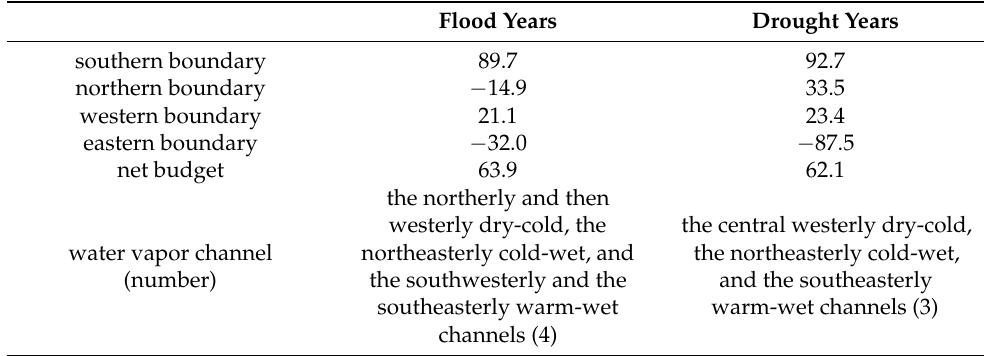
Figure 7. Composite of the LF column-integrated water vapor flux of 10–20 days (vector, kg/(m·s), significant at α = 0.1 level) and the corresponding LF water vapor flux divergence fields (shaded, kg/(m 2 ·s)) based on the peak of phase 3 ( a , b ) of LF precipitation of 10–20 days in flood ( a ) and drought ( b ) years. A and C represent anticyclonic and cyclonic water vapor circulation, respectively, and the long red trajectories are drawn as a schematic diagram of water vapor channels. Table 2. Composite of the LF water vapor income at each boundary (10 6 kg/s), net water vapor budget (10 6 kg/s), and water vapor channels of southern China based on the peak of phase 3 of LF precipitation of 10–20 days in flood and drought years.